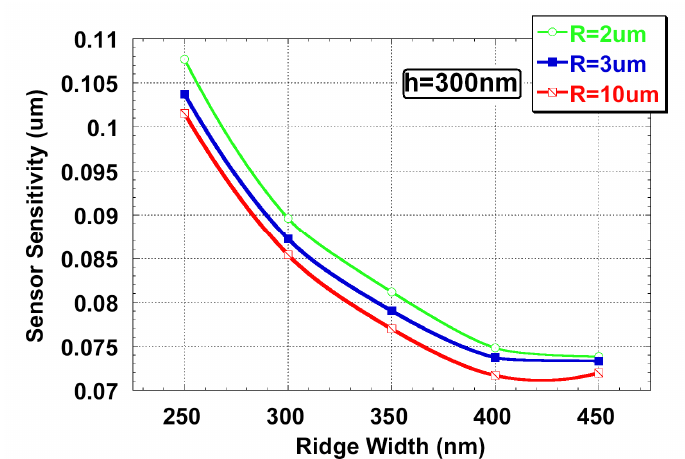
Figure 4 . Device sensitivity versus ridge width, numerically estimated by formula (6) (quasi-TM mode).